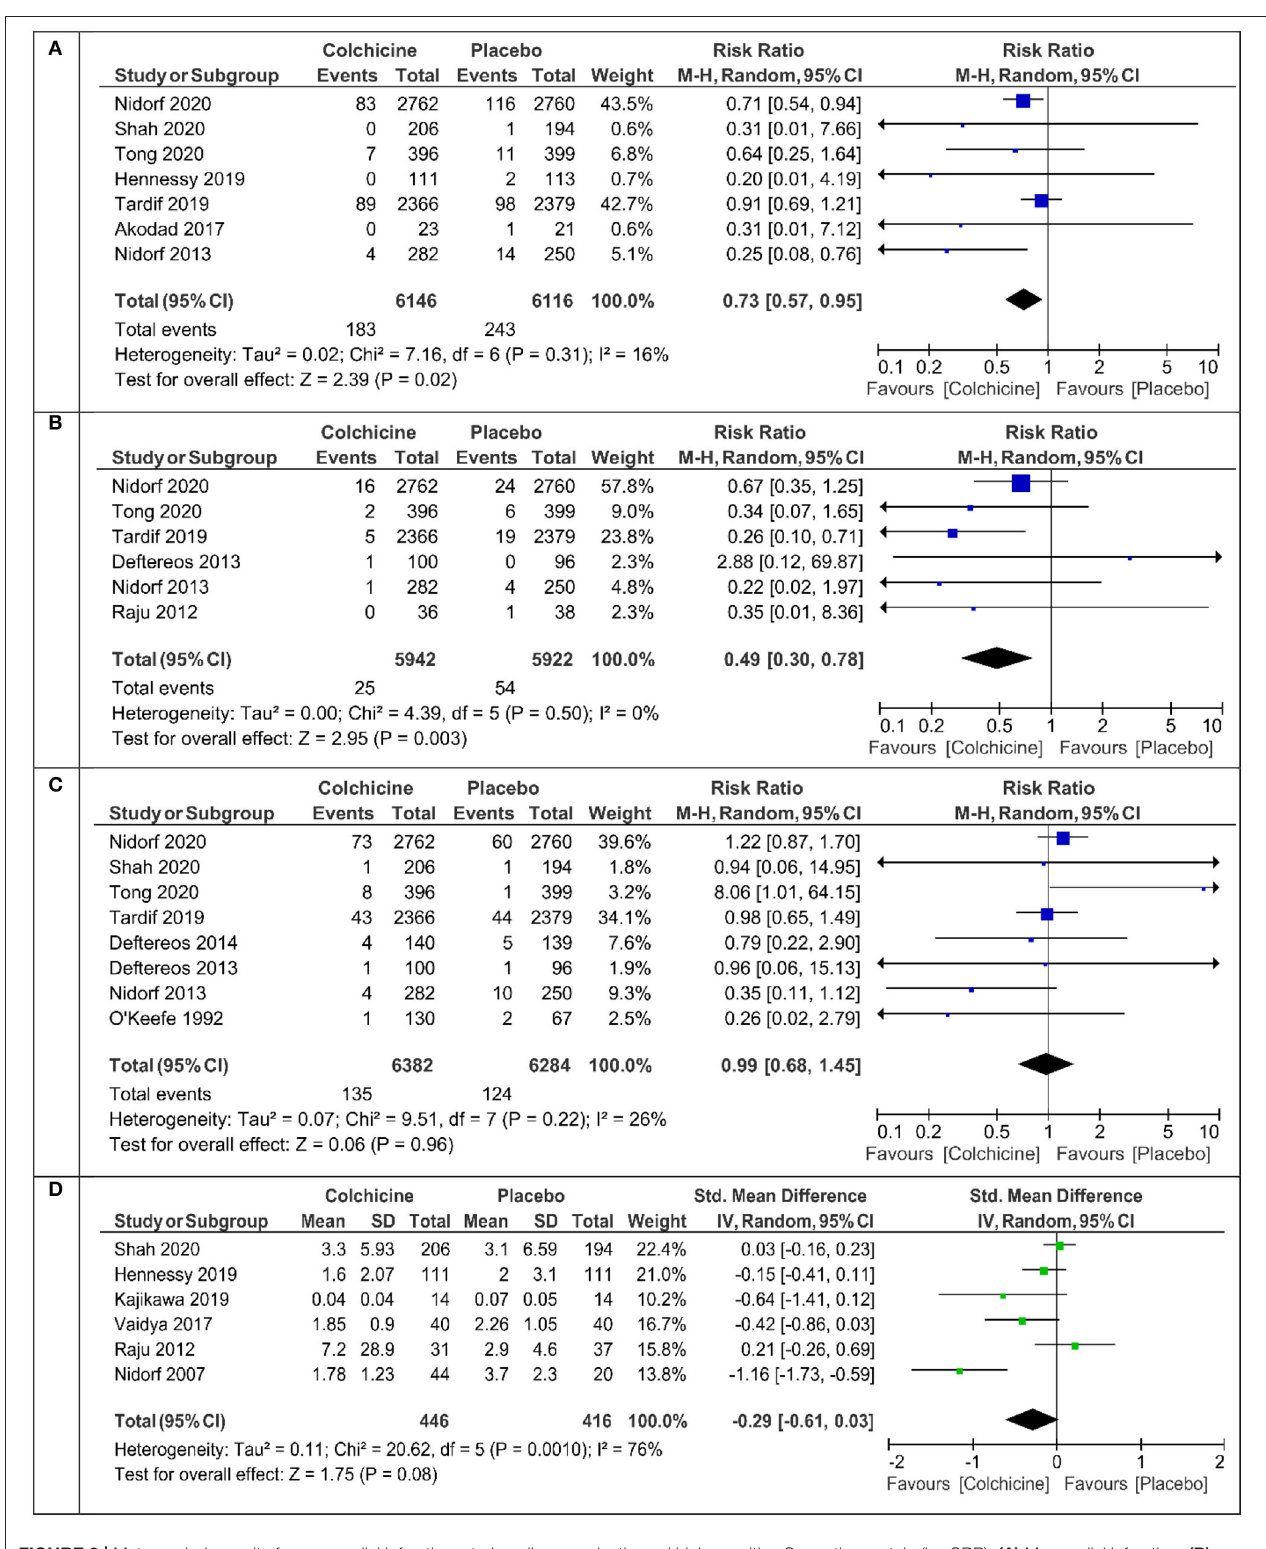
Frontiers in Cardiovascular Medicine |